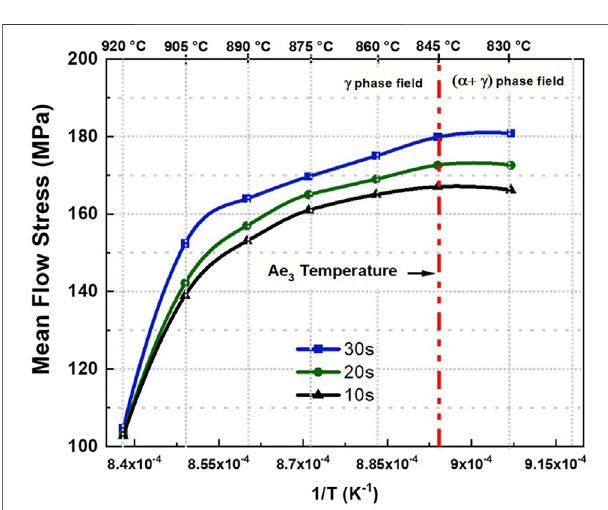
FIGURE 3 | The calculated mean fl ow stress (MFS) of X70 during the physical simulation of hot plate rolling. The increase and decrease in MFS can be associated with strain accumulation and activation of softening phenomena such as phase transformation and